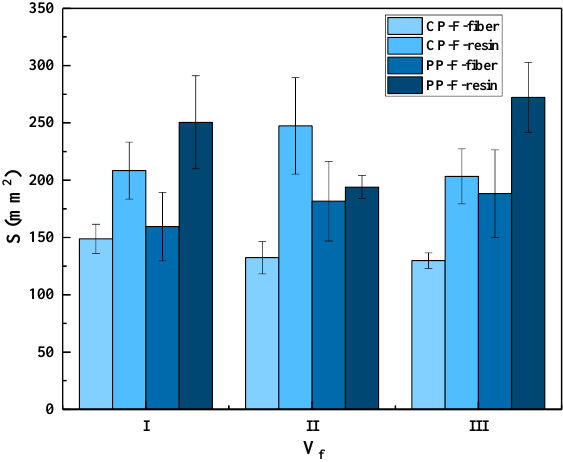
Figure 9. Fiber/resin damage area of composite panel after ballistic test of front face. Statistics for the fiber damage areas and resin damage areas on the back faces of the tested panels are shown in Figure 10. Combined with Figure 8 and Figure 9, the figure shows that the area of fiber damage on the back face is only slightly larger than that on the front. This shows that the energy dissipation mode of the 3DWCs is mainly shearing when CP occurs. In the case of PP, the resin damage area on the back face is much larger than on the front face. This indicates that the failure mode in PP is more complex. In regard to the energy dissipation mechanism, the front face is dominated by fiber and resin shear- ing, while the back face includes resin cracking, fiber-resin interface damage, fiber tensile deformation and fracture. The resin damage area on the back face in CP is much smaller than that in PP. Therefore, it can be said that the increase in the damage resin area on the back face is helpful to improve the protective performance of 3DWCs. With the increase of V f , the resin damage area on the back face of the 3DWCs shows a significant upward trend. Therefore, the increase in V f helps to increase the amount of fibers and resin in- volved in energy dissipation by increasing the damage area on the back side, thus con- tributing to the improvement of ballistic protection performance.